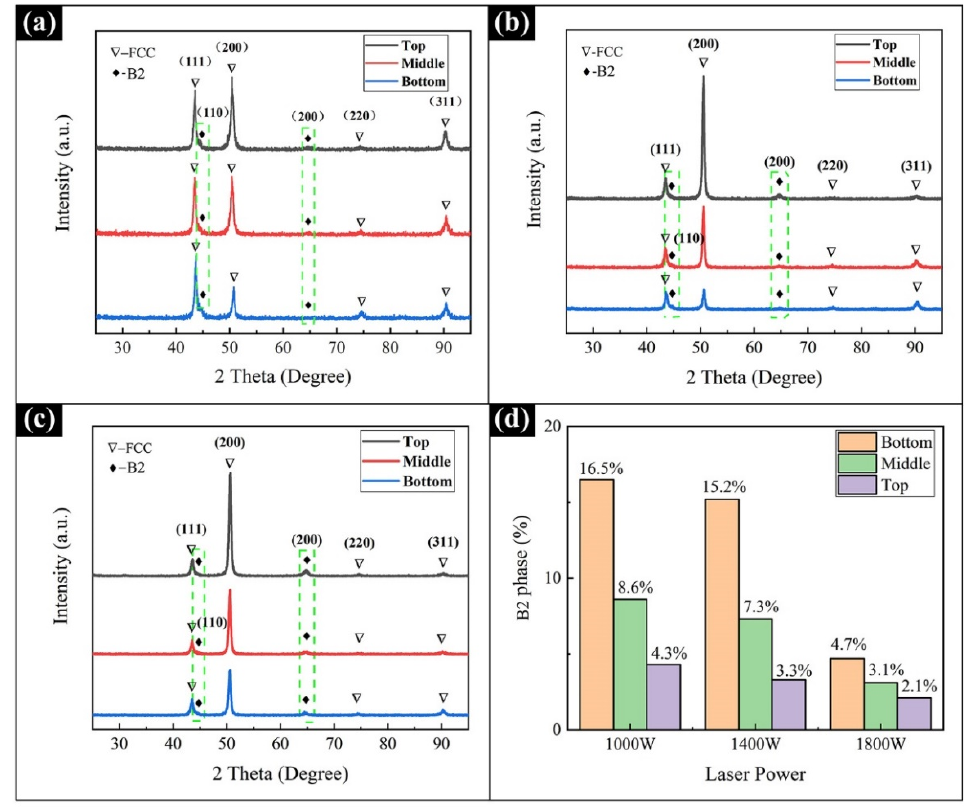
Figure 5. The XRD results of the Al 0.5 FeCoCrNi HEA manufactured by LMD with different laser powers: ( a ) 1000 W; ( b ) 1400 W; ( c ) 1800 W. ( d ) Fractions of B2 phase in different